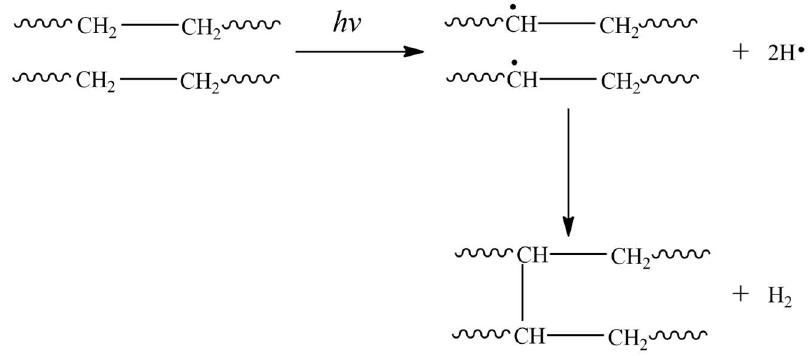
Figure 6. Representative scheme of the HE-EMR radiation crosslinking process.